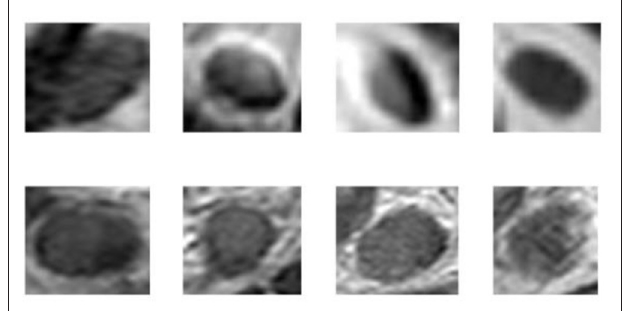
FIGURE 1 | Sample CRC LN images (top row, negative; bottom row,